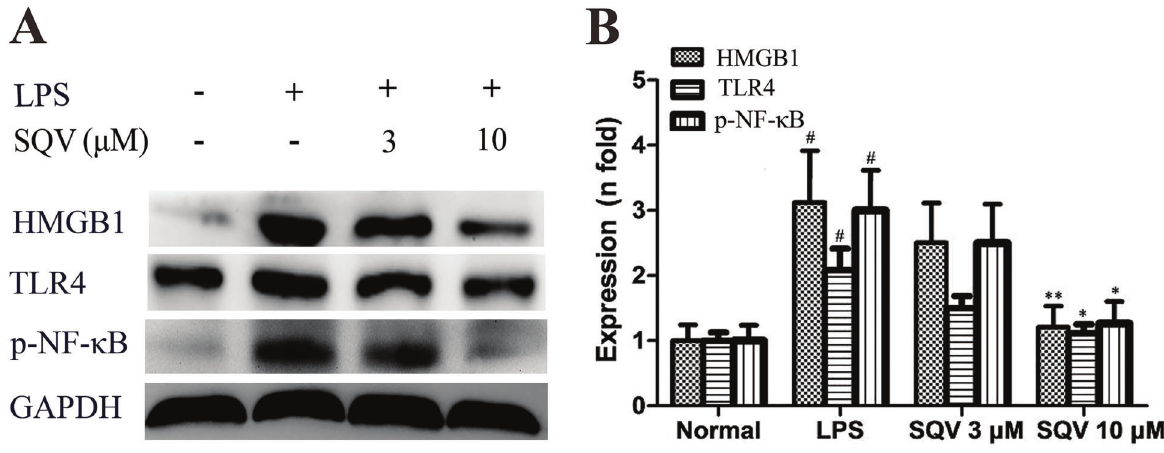
Figure 2. Effects of saquinavir (SQV) on high mobility group box 1 (HMGB1), toll-like receptor 4 (TLR4), and phospho-NF- k B (p-NF- k B) intensity in lipopolysaccharide (LPS)-prompted alveolar macrophages by western blotting. Data are reported as % above normal and means ± SD (n=5). # P o 0.01 vs the normal group. *P o 0.05, **P o 0.01 vs the LPS group (ANOVA with Dunnett ’ s test).